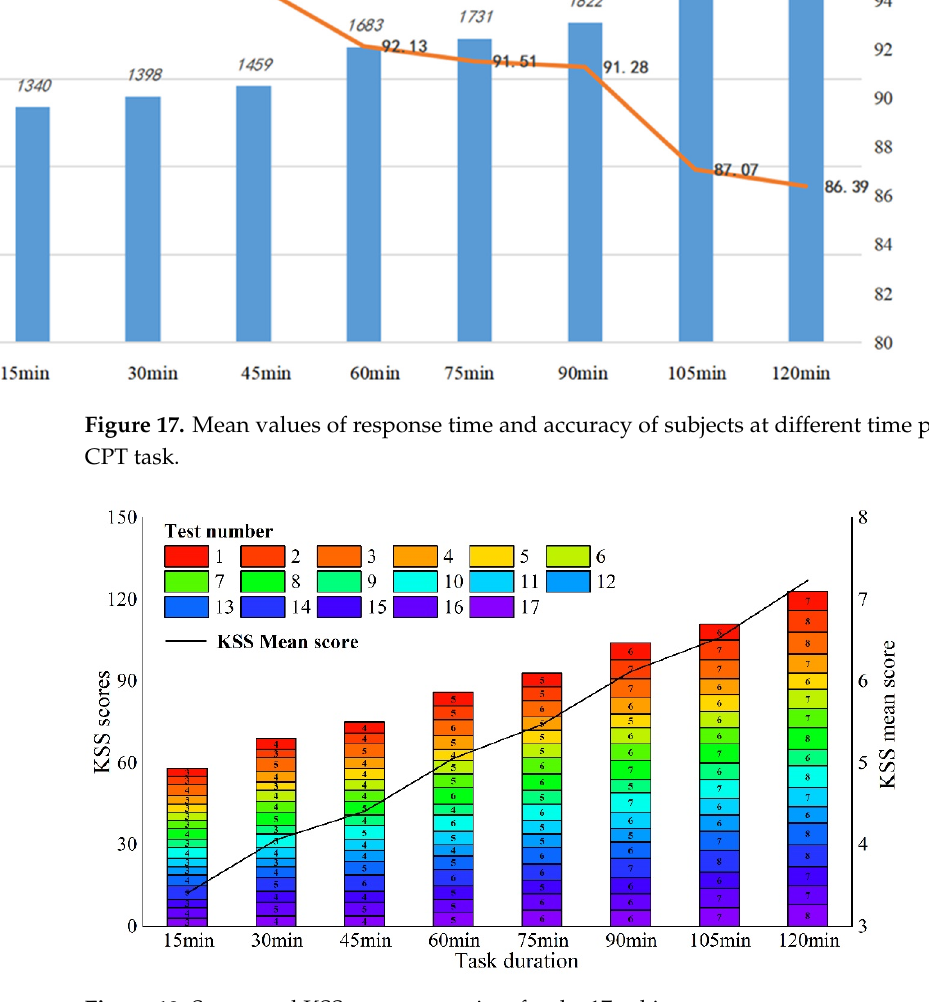
Figure 18. Scores and KSS means over time for the 17 subjects.